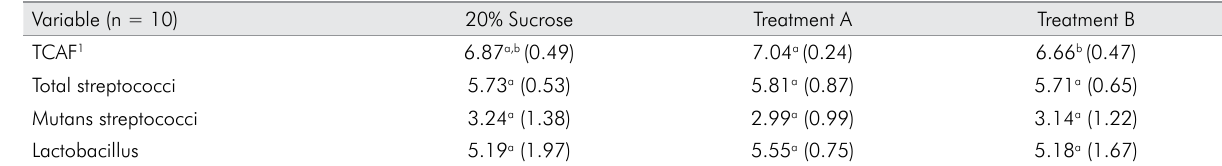
Table 2. Mean and standard deviation (SD) of microorganisms in the biofilm (log CFU/mg) after 14 days (in situ study). Variable (n = 10) 20%